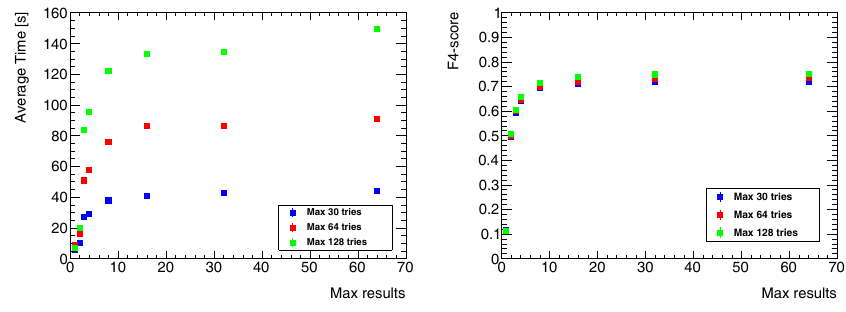
Figure 5. MPC algorithm performance. Left: Average processing time vs maximum number of results. Right: F 4 -score vs maximum number of